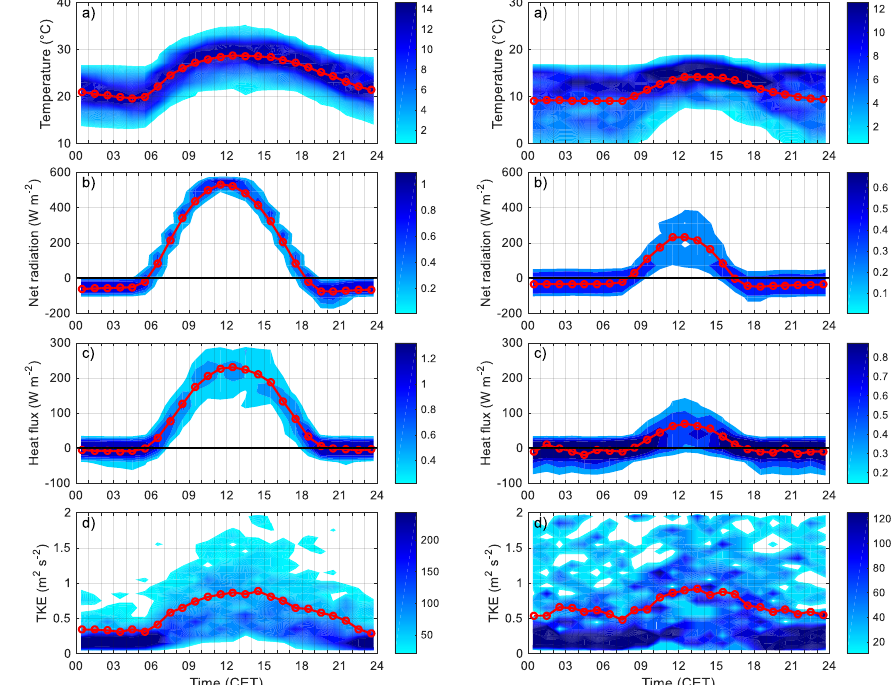
Figure 11. Diurnal behaviour of the occurrence of the relevant meteorological and turbulent parameters: ( a ) Temperature, ( b ) net radiation, ( c ) sensible heat flux, and ( d ) turbulent kinetic energy (TKE) for the summer months June–August in 2015 and 2016 (left panels) and for the winter months December–February 2015–2016 (right panels). In all graphs, the colour intensity is proportional to the probability density functions of the variables multiplied by 100. Red lines indicate the mean values.